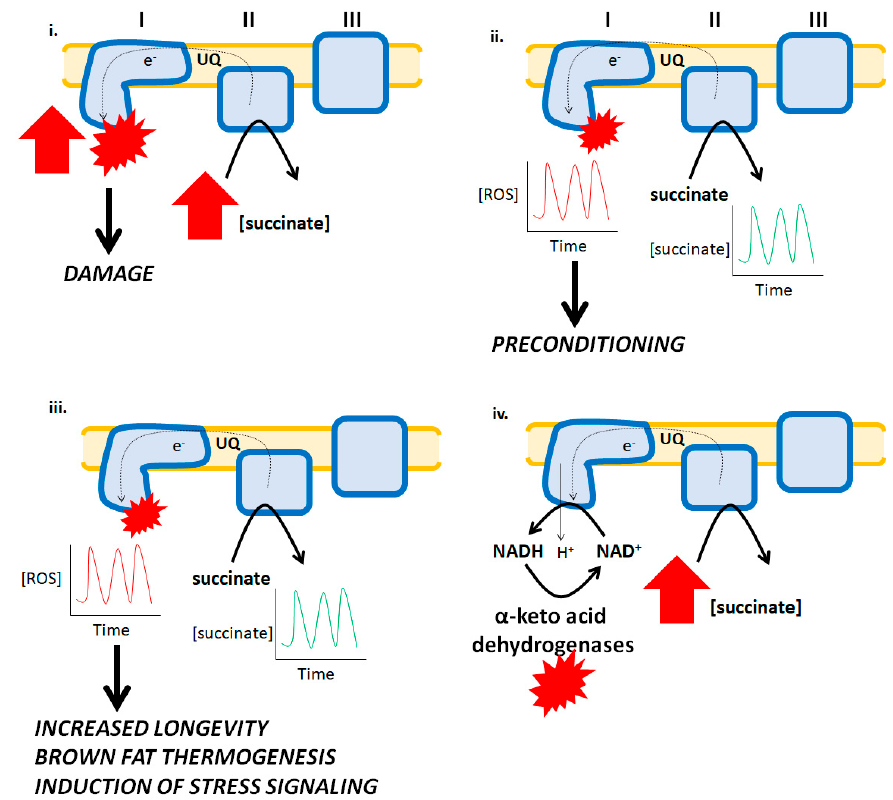
Figure 2. Reverse electron transfer (RET) and its pathological effects and physiological benefits. i . The accumulation of succinate during ischemia results in a high burst in ROS production by complex I.